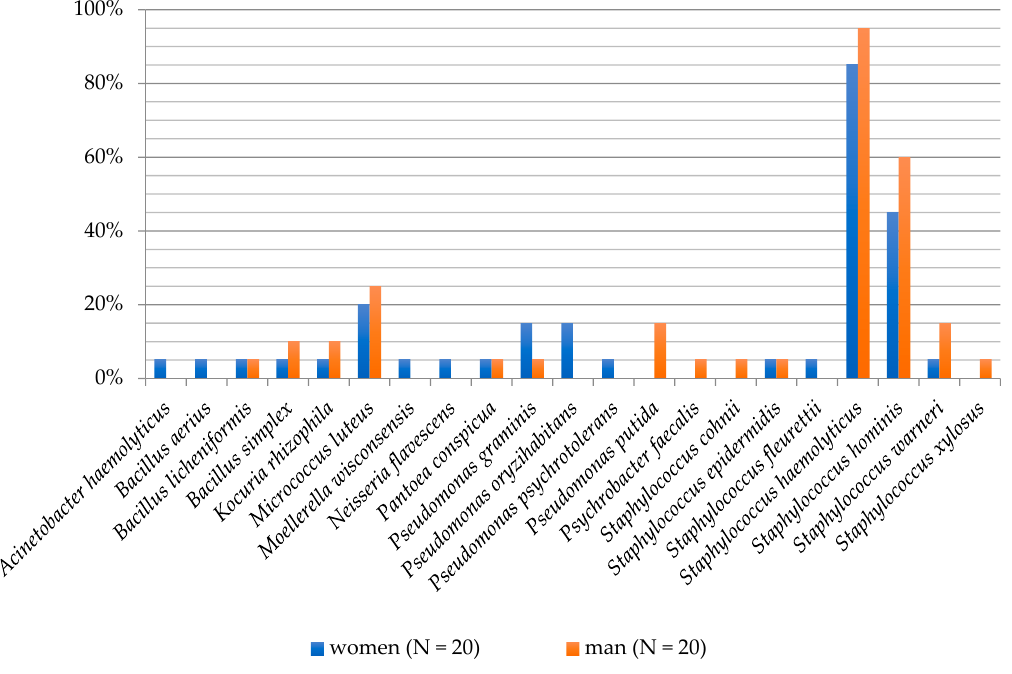
Figure 1. Frequency of the occurrence of bacteria on the foot skin depending on the gender of examined people.